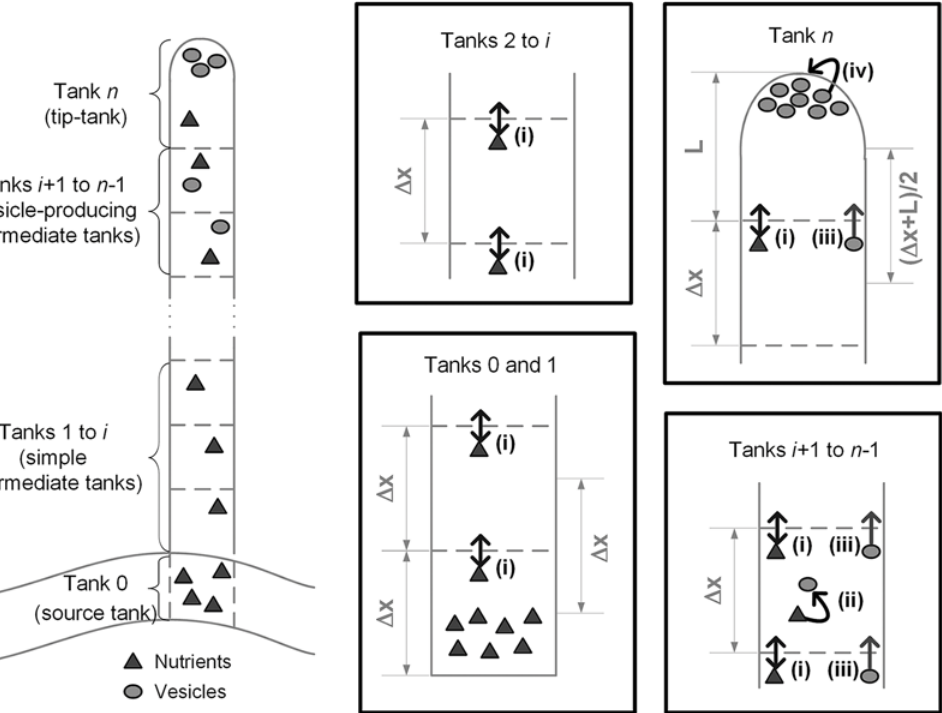
Fig 2. Description of a non-septate reproductive hypha as a series of well-mixed tanks. Phenomena are denoted by capital letters: (i) Nutrient is provided by the vegetative hypha (tank 0) at the base of the reproductive hypha (tanks 1 to n ) and moves towards the tip (tank n ) by diffusion between the tanks and convective flow of the cytoplasm. This convective flow is due to evaporation at the hyphal tip; (ii) In the vesicle-producing zone (tanks i +1 to n -1), nutrient is used to produce vesicles containing cell wall precursors; (iii) The vesicles move towards the tip with a fixed velocity (i.e. there is no diffusive contribution to their transport) that can be different from that of the cytoplasm; (iv) The tip (tank n ) extends due to the absorption of